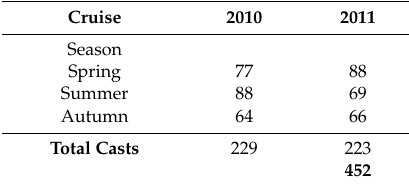
Table A1. The numbers of CTD casts deployed during each cruise.